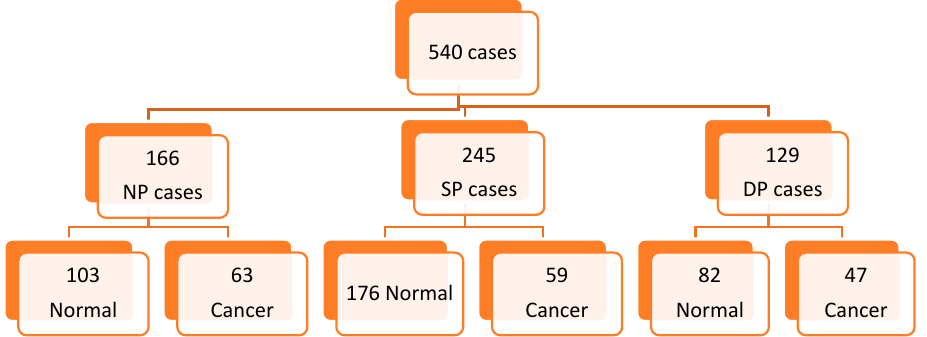
Figure 1. Case distribution among different categories (NP—without prior images, SP—with prior images from same vendor, DP—with prior images acquired from different vendor).